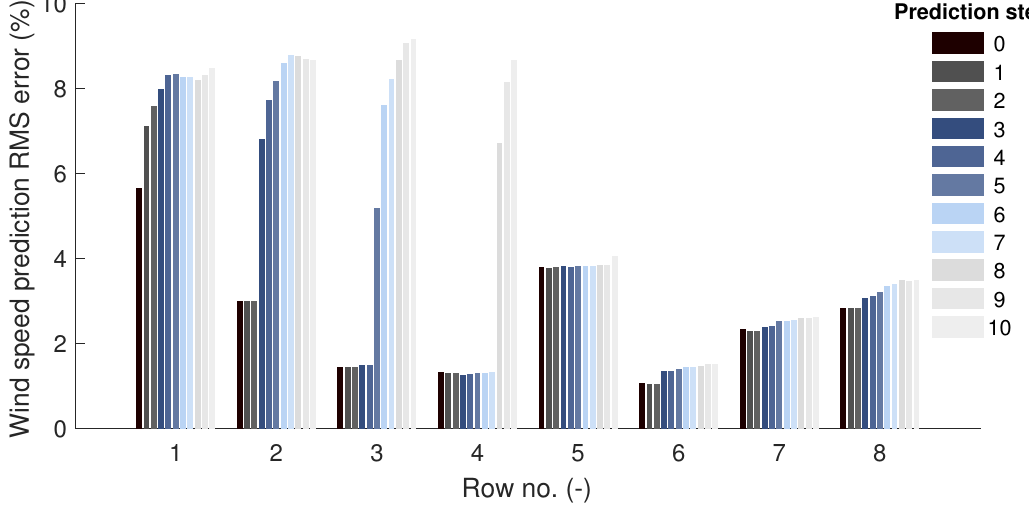
Figure 12. Accuracy of 10-step ahead prediction of rotor effective wind speed at rows of large-scale wind farm. Accuracy is normalized RMS difference between DFP prediction and SWF flow model averaged over turbine rows. Kalman filter in DFP is